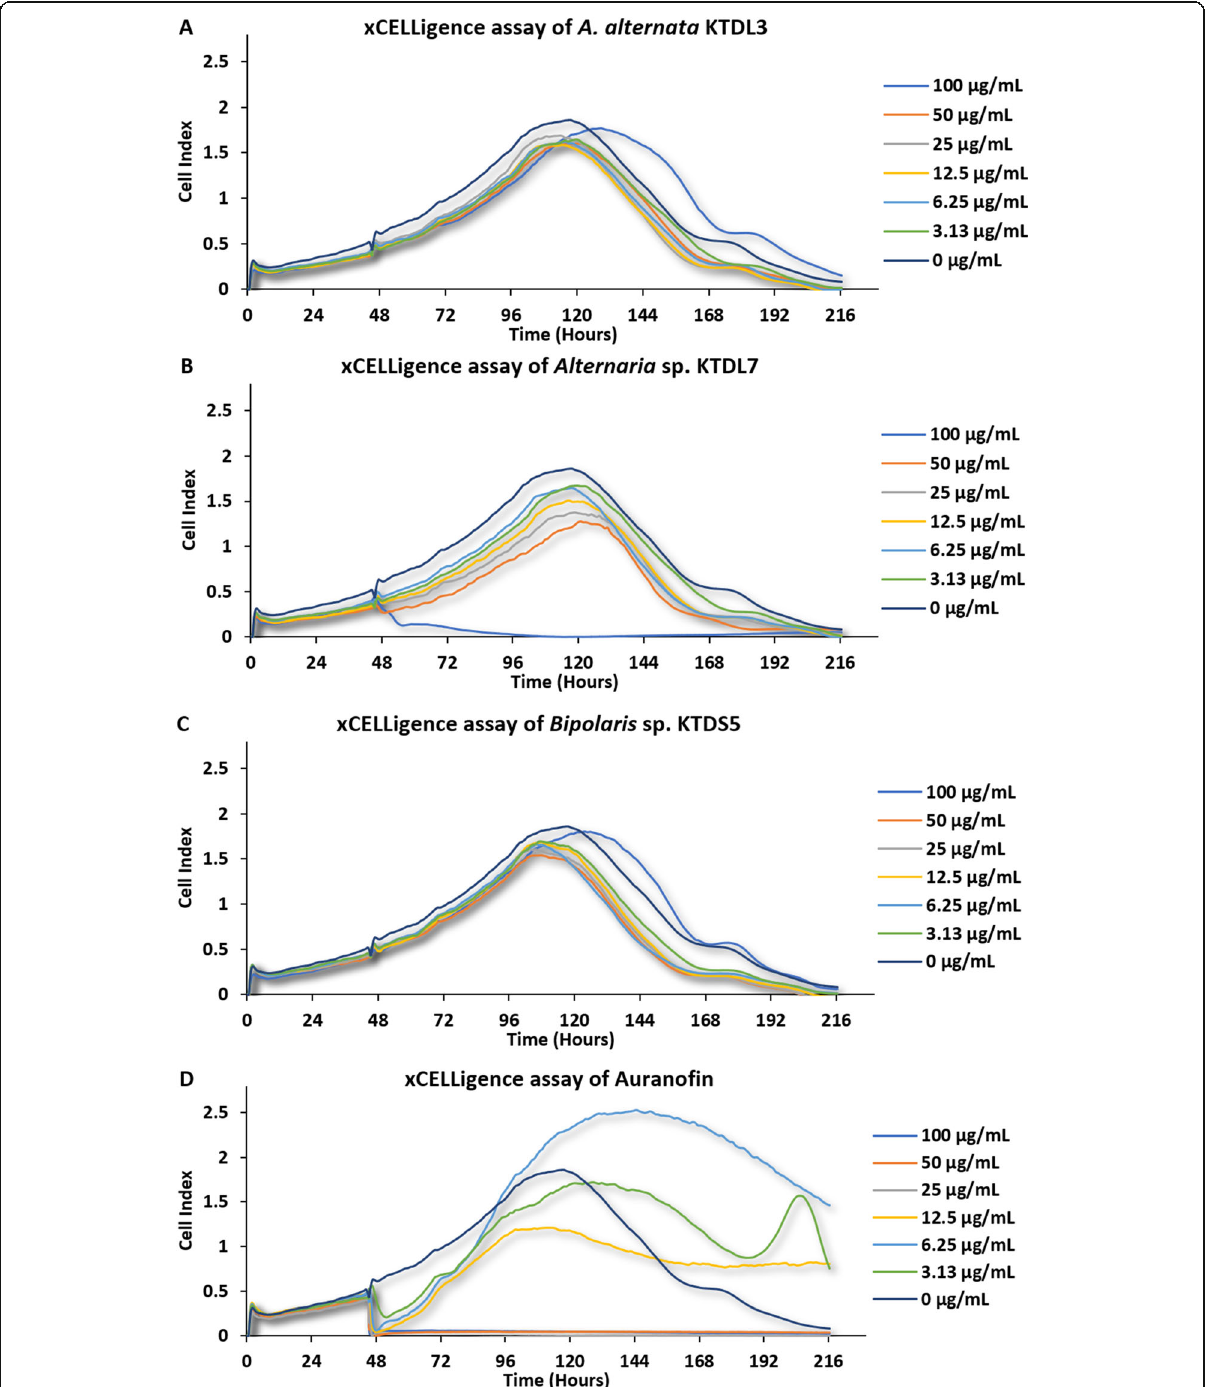
Fig. 3 Real-time analysis of the bioactivity of crude fungal extracts on UMG87 glioblastoma cells. Extracts from Alternaria alternata KTDL3 ( a ), Alternaria sp. KTDL7 ( b ), and Bipolaris sp. KTDS5 ( c ) were administered in six concentrations ranging from 0 to 100 μ g/mL on the 45th hour on the timeline and the response of the cells was monitored up until the 216th hour. Cell viability was recorded as cell index, which is a relative change in measured impedance. Auranofin ( d ) was used as a positive